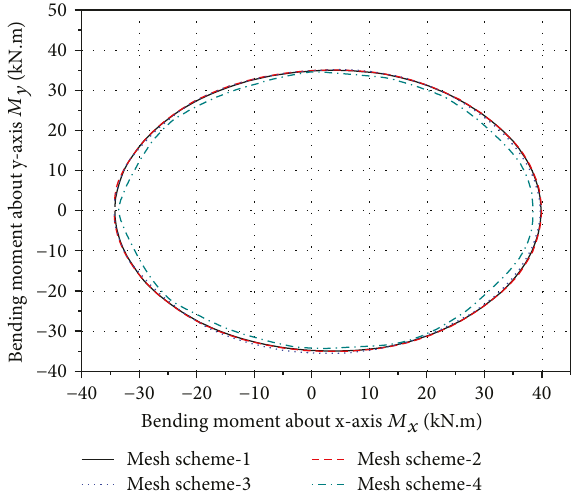
− M Figure 6: M x y interaction curve with di